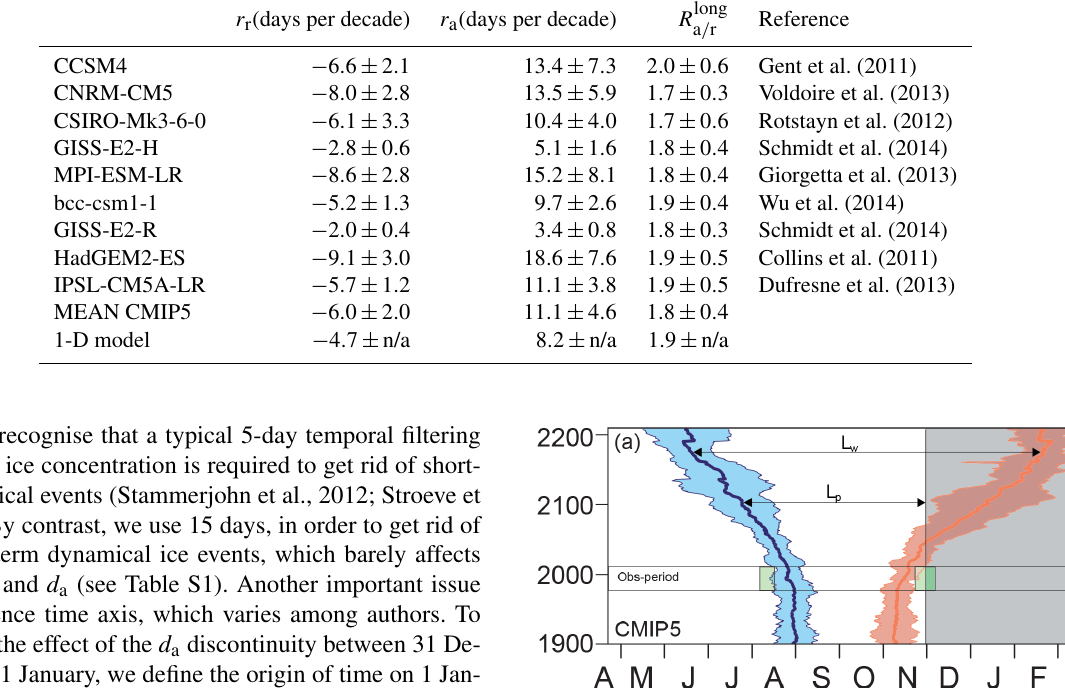
Table 1. Linear trends in ice retreat and advance dates over 2000–2200 (200 years), and long-term ice advance amplification ratios for the individual and mean CMIP5 models and for the 1-D model. Trends and ratios are given as median ± interquartile range over the seasonal ice zone in which trends are significant at a 95% confidence level ( p = 0 . 05). n/a: not applicable. r r (days per decade) r a (days per decade) R long a / r